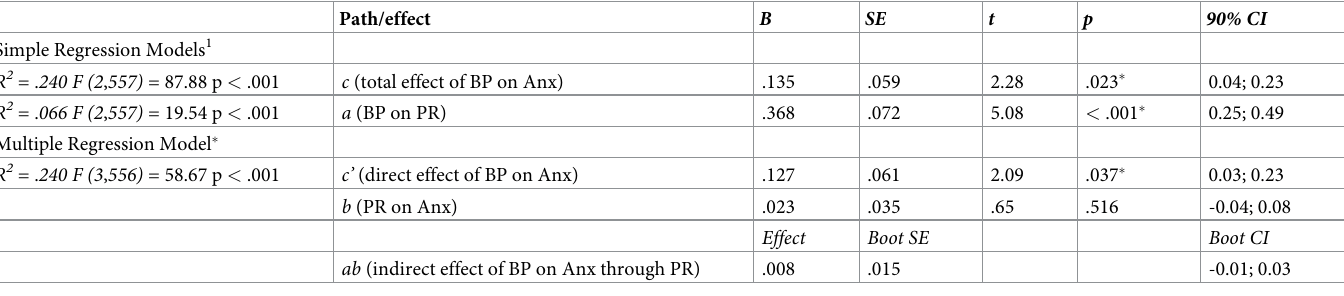
Table 7. Mediation analysis for the association between behavioral problems in adolescence and anxiety in young adulthood via parental rejection.